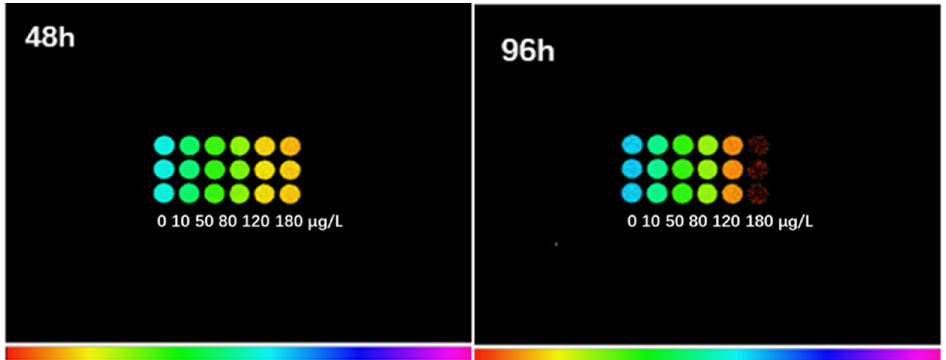
Figure 5. Fluorescence images of chlorophyll in S. obliquus after exposure to ENR for 48 h and 96 h. The colors indicate the degree of algal damage; the redder the color, the more serious the damage.